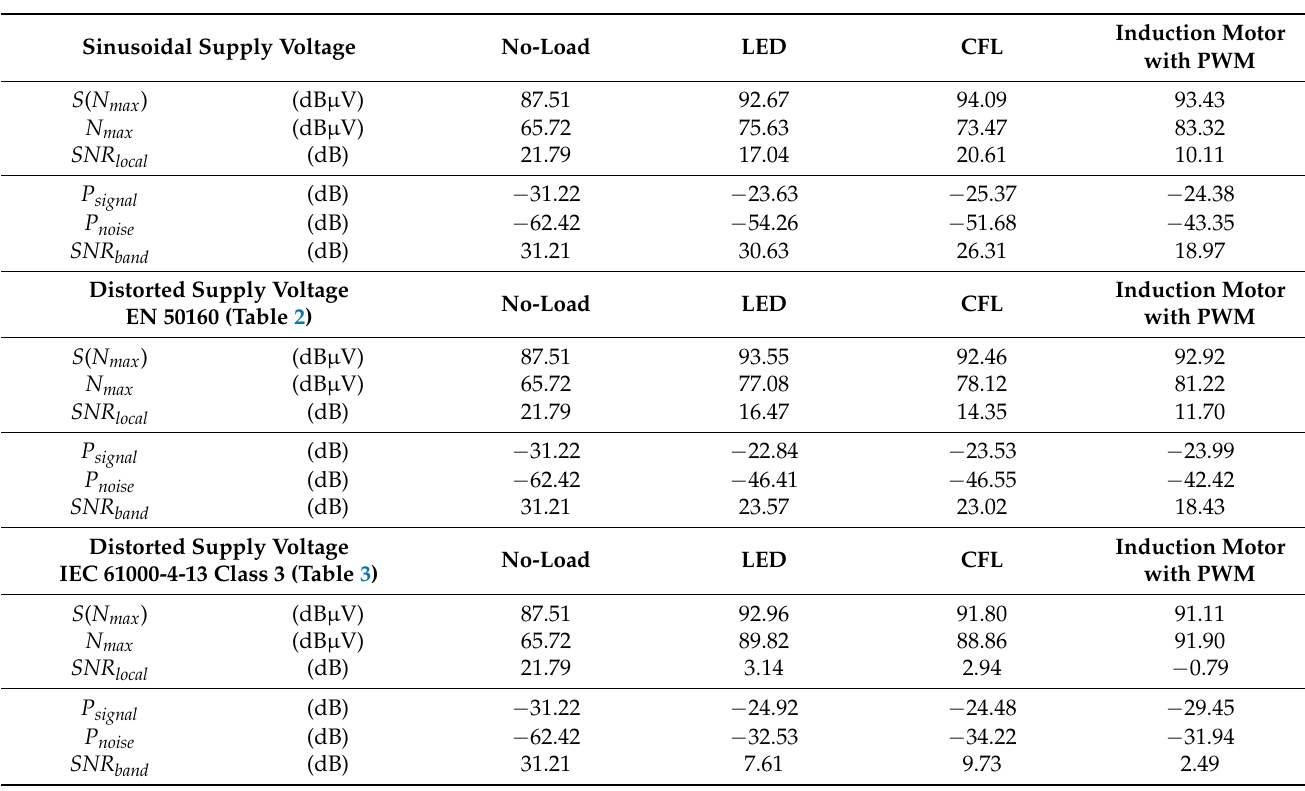
Table 4. Characteristic parameters of the signal in the transmission band 42–89 kHz of PRIME PLC during the different scenarios of supply voltage distortion and variant types of